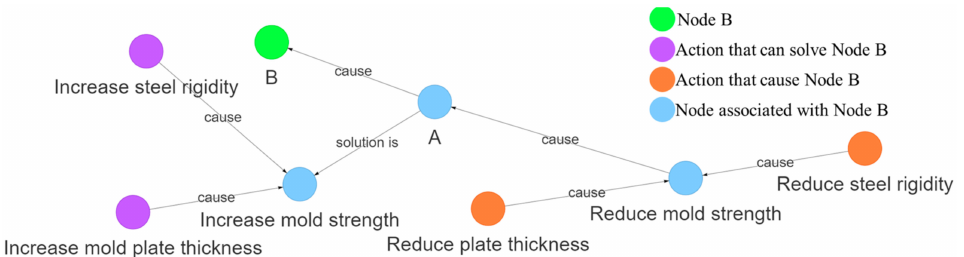
Figure 16. Search result of case 1.